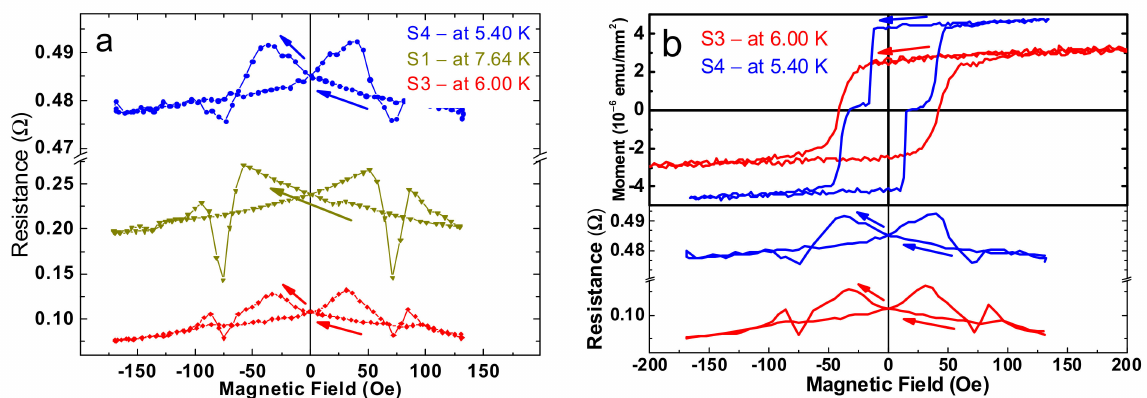
Figure A1. ( a ) R ( H ) dependences of the single VN film (S1), the heterostructure VN/Pd 0.92 Fe 0.08 (S3), and the pseudo-spin- valve structure Pd 0.96 Fe 0.04 /VN/Pd 0.92 Fe 0.08 (S4). ( b ) Magnetoresistance data for Samples S3 and S4 are shown in the lower panel in conjunction with the magnetic hysteresis loops in the upper panel for the same samples measured in identical geometries of the